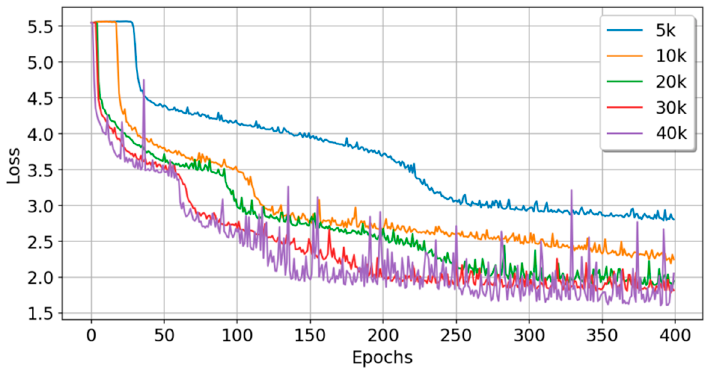
Figure 26. LSTM loss values under different scales of data.